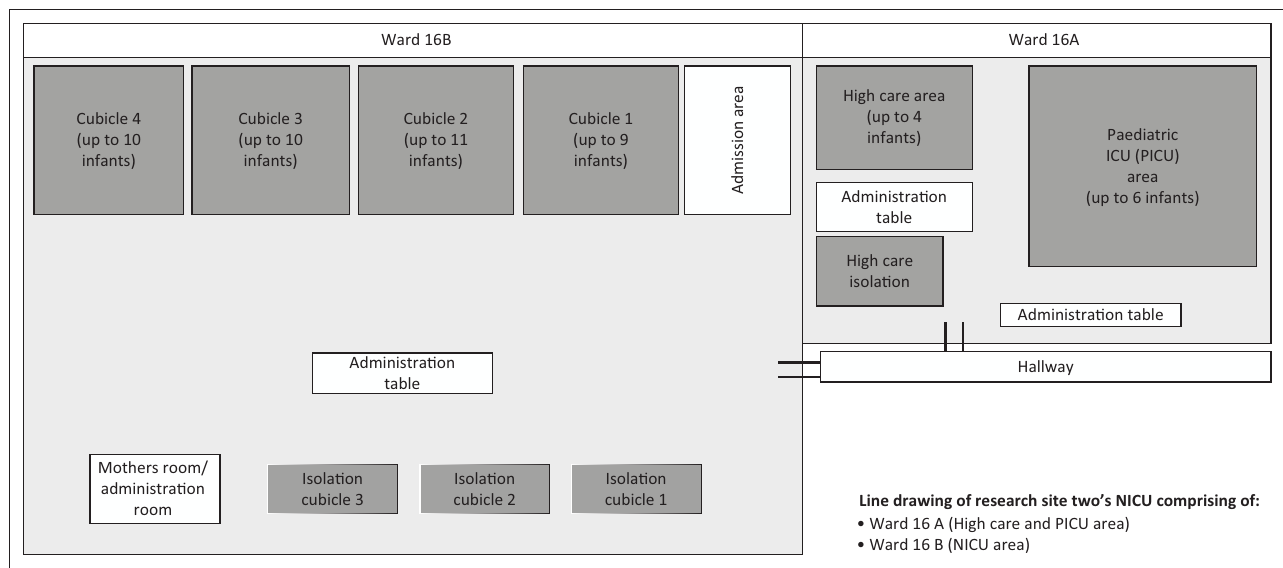
FIGURE 1: Research site 1 layout.